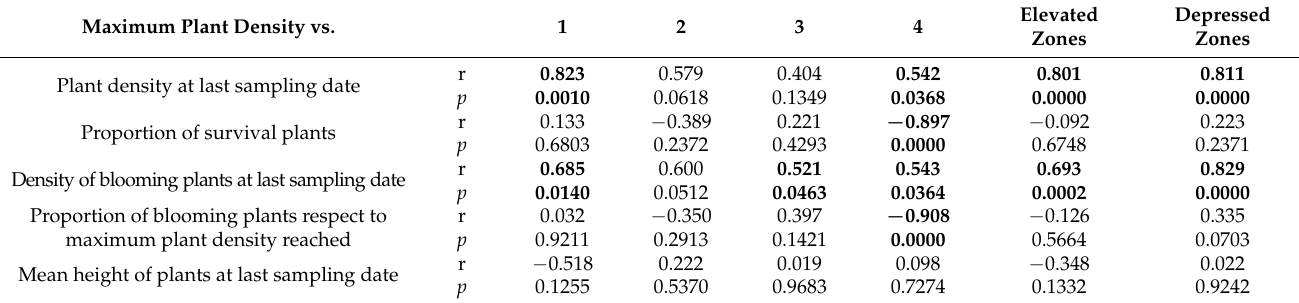
Table 4. Spearman correlation coefficient ( ρ ) and probability value ( p ) for correlations between daily variation in plant density in proportion to maximum density (plants m − 2 ), and daily variation in different environmental variables for four populations of Salicornia ramosissima and for populations in elevated and depressed zones. Significant values are marked in bold ( p <